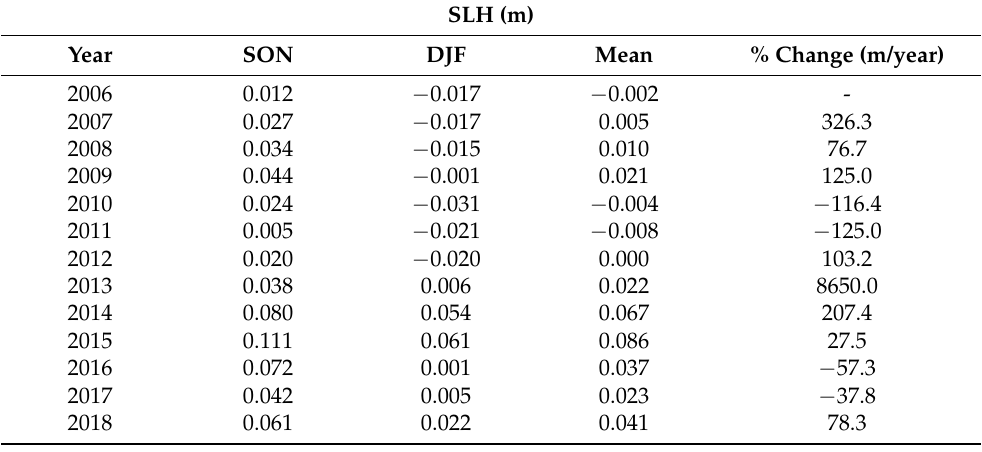
Table 3. MEaSUREs annual percentage change of sea level heights in the target area.